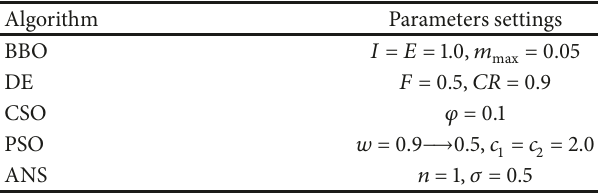
Table 1: Parameter settings of different algorithms.